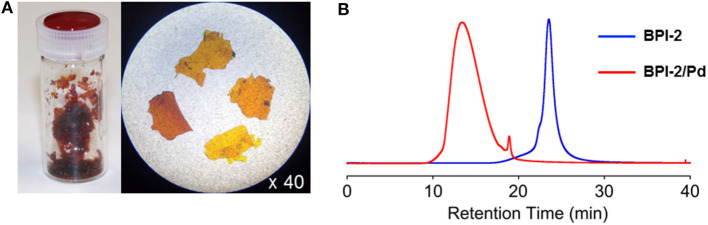
(A) Photos of film-like solid samples of BPI-2/Pd complex. (B) SEC profiles of BPI-2 and BPI-2/Pd complex monitored at 424 and 420 nm, respectively, in SEC. [Conditions] Column: TOSOH TSKgel G4000HXL + G4000HHR, Solvent: CHCl3, Flow speed: 1 mL/min, Temperature: 20°C.